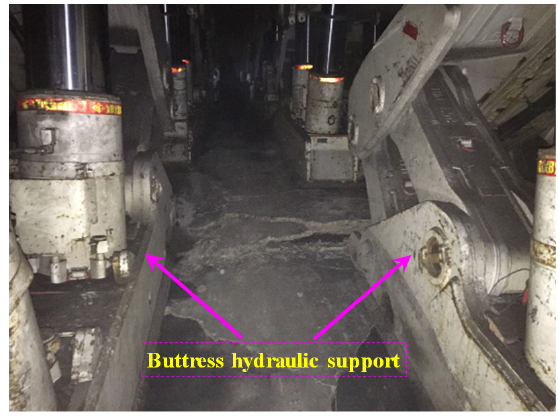
Figure 15. Photos of buttress hydraulic supports on site.